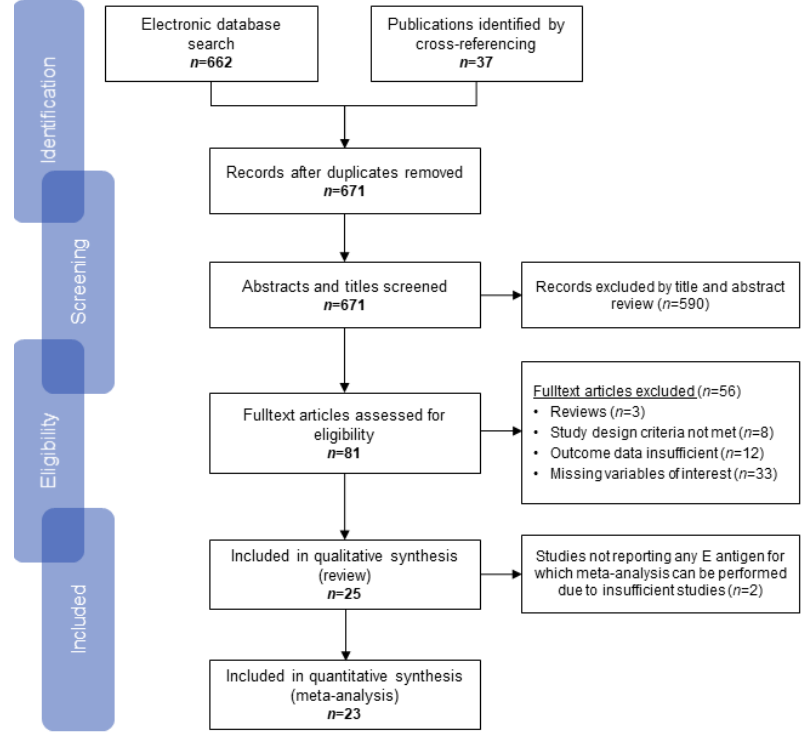
Figure 1. PRISMA flow diagram of study selection process [17].